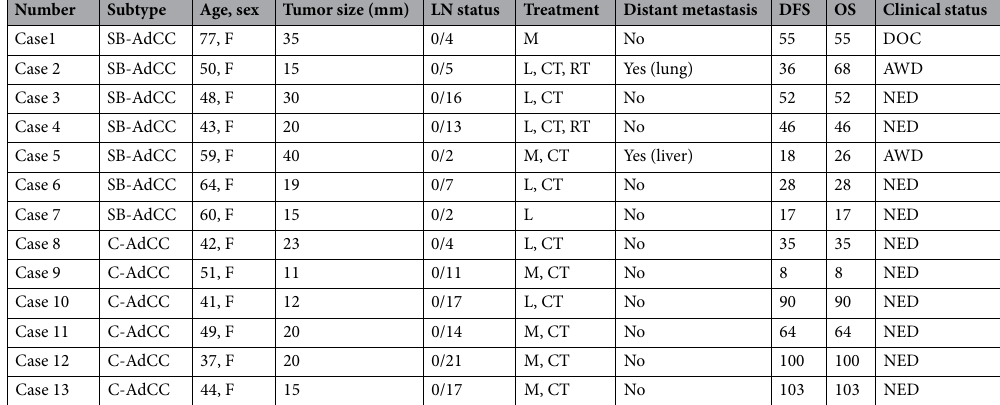
Table 2. Treatment and outcome of the SB-AdCC and C-AdCC Groups. F female, L lumpectomy, M mastectomy, CT chemotherapy, RT radiotherapy, DOC death of other cause, AWD alive with disease, NED no evidence of disease.